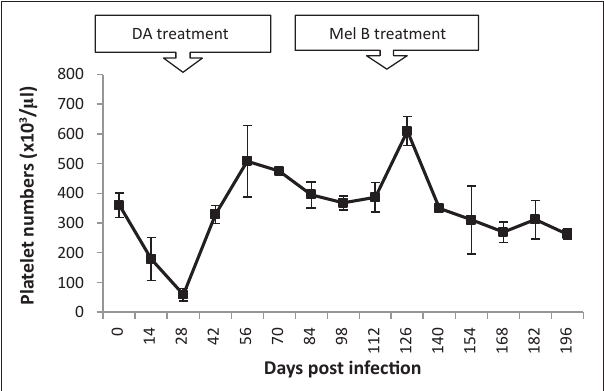
FIGURE 6: Changes in mean platelet numbers in vervet monkeys infected with T. b. brucei GUTat 1, showing the point of subcurative treatment with diminazene aceturate (DA) (28 dpi) and curative treatment with melarsoprol (Mel B) (119